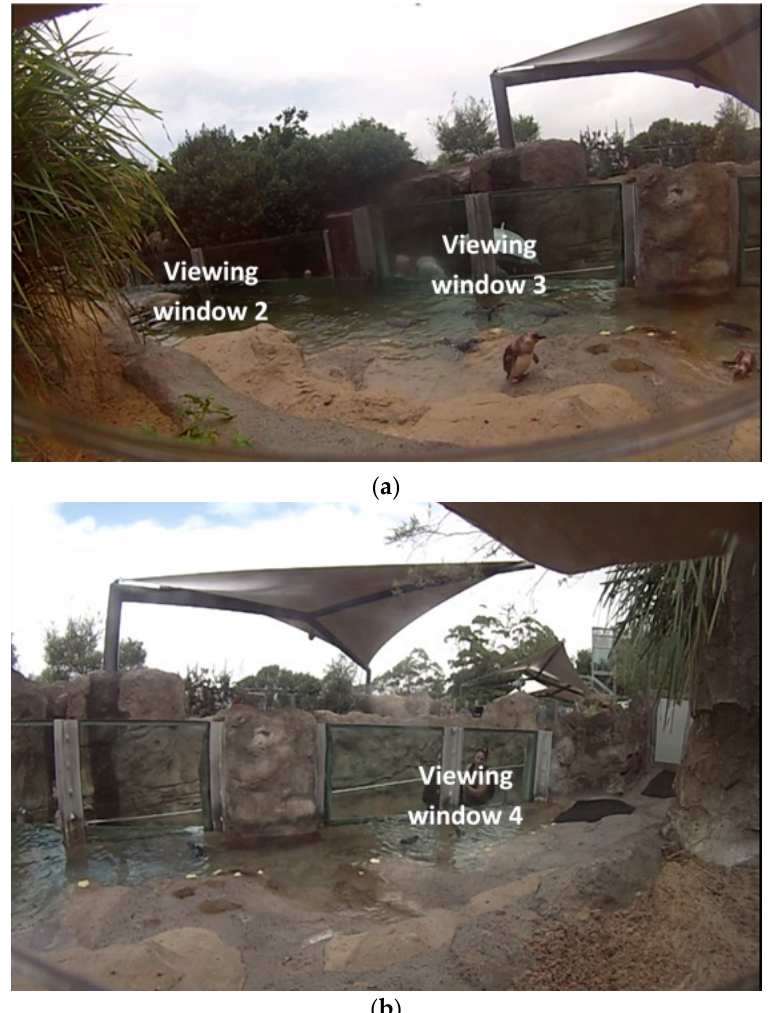
Figure 4. Camera fields of view ( a ). ‘Corner’ area (not visible to visitors); ( b ). ‘Main visitor viewing area window’ area (above water); ( c ). ‘Main visitor viewing area window’ area (underwater).